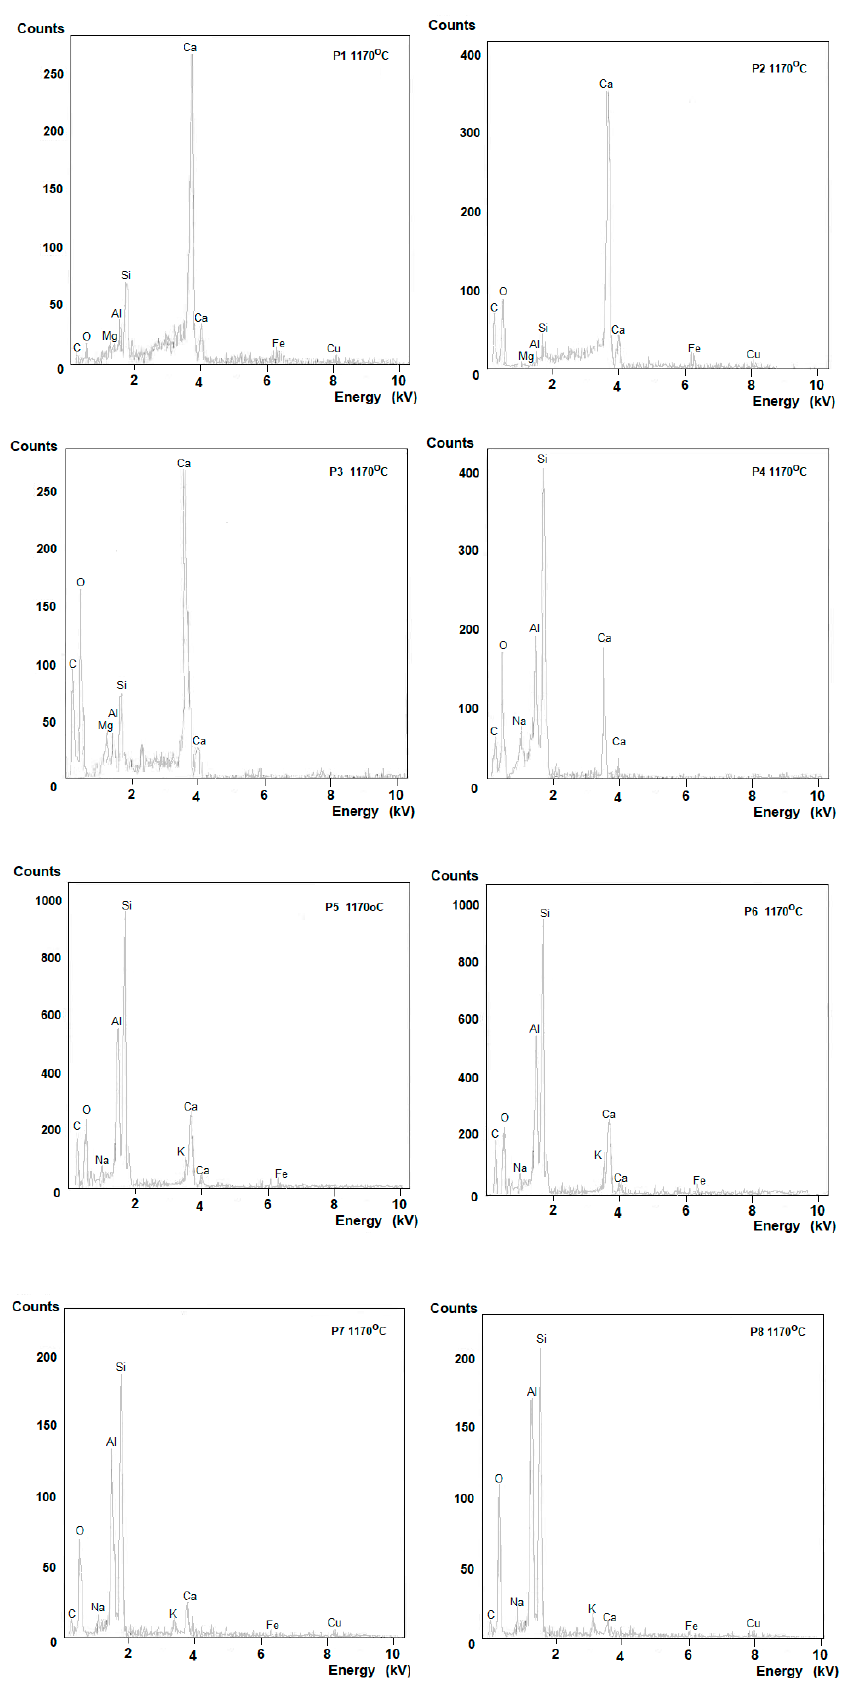
Figure 8. EDS analysis of the tested samples at the points marked in Figure 6.